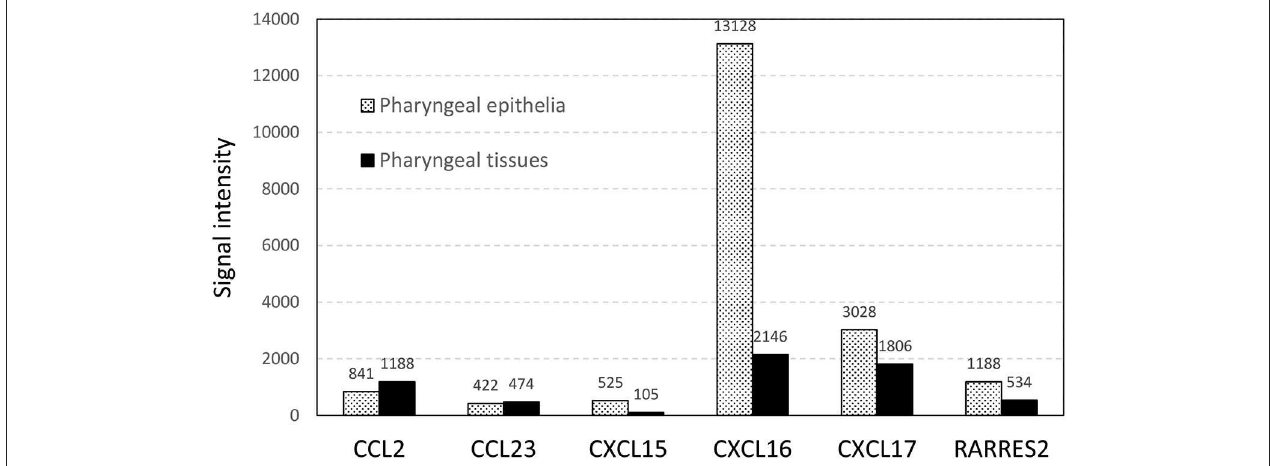
FIGURE 2 | The normalized microarray signal intensity (photons per pixel) of six differentially expressed chemokines in total RNA prepared from micro-dissected pharyngeal epithelia and whole pharyngeal